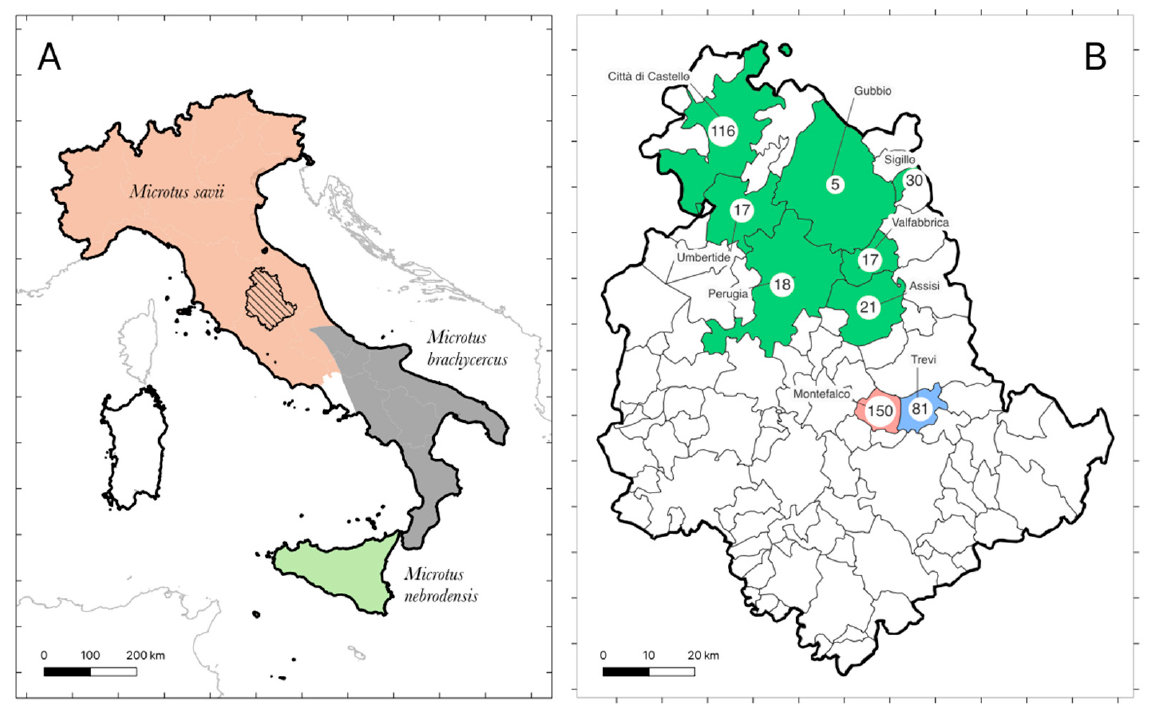
Figure 2. ( A ) Presumptive distribution of Microtus savii (orange), M. brachycercus (gray) and M. nebrodensis (green) (redrawn from [2]). ( B ) Map of the municipalities of the Umbria region. Microtus sp. Geographical populations are shown with di ff erent colours: red (Montefalco), light blue (Trevi), and green (North and Central provinces of Perugia).